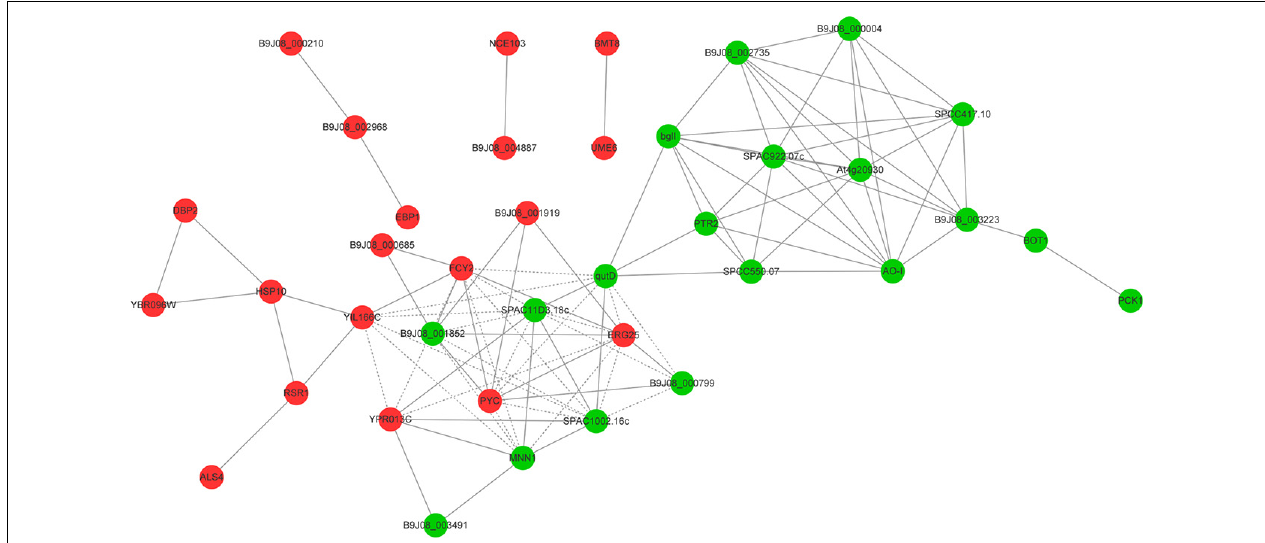
FIGURE 5 | A predicted protein–protein interaction network. The top 20 upregulated DEGs and top 20 downregulated DEGs constitute the predicted protein interaction network using the STRING (Search Tool for the Retrieval of interacting Genes) database. The red and green nodes with gene names represented upregulated and downregulated differentially expressed genes,